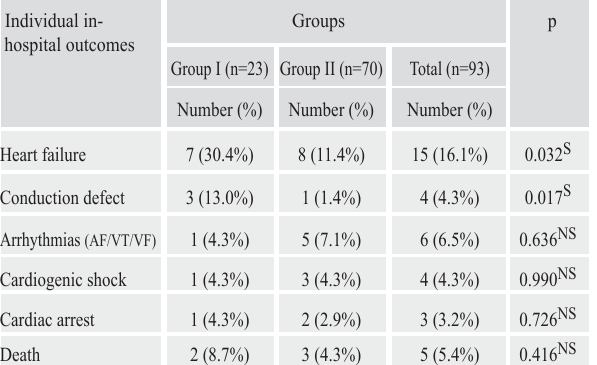
Table V: Comparison of in-hospital outcomes between two groups (N=93)